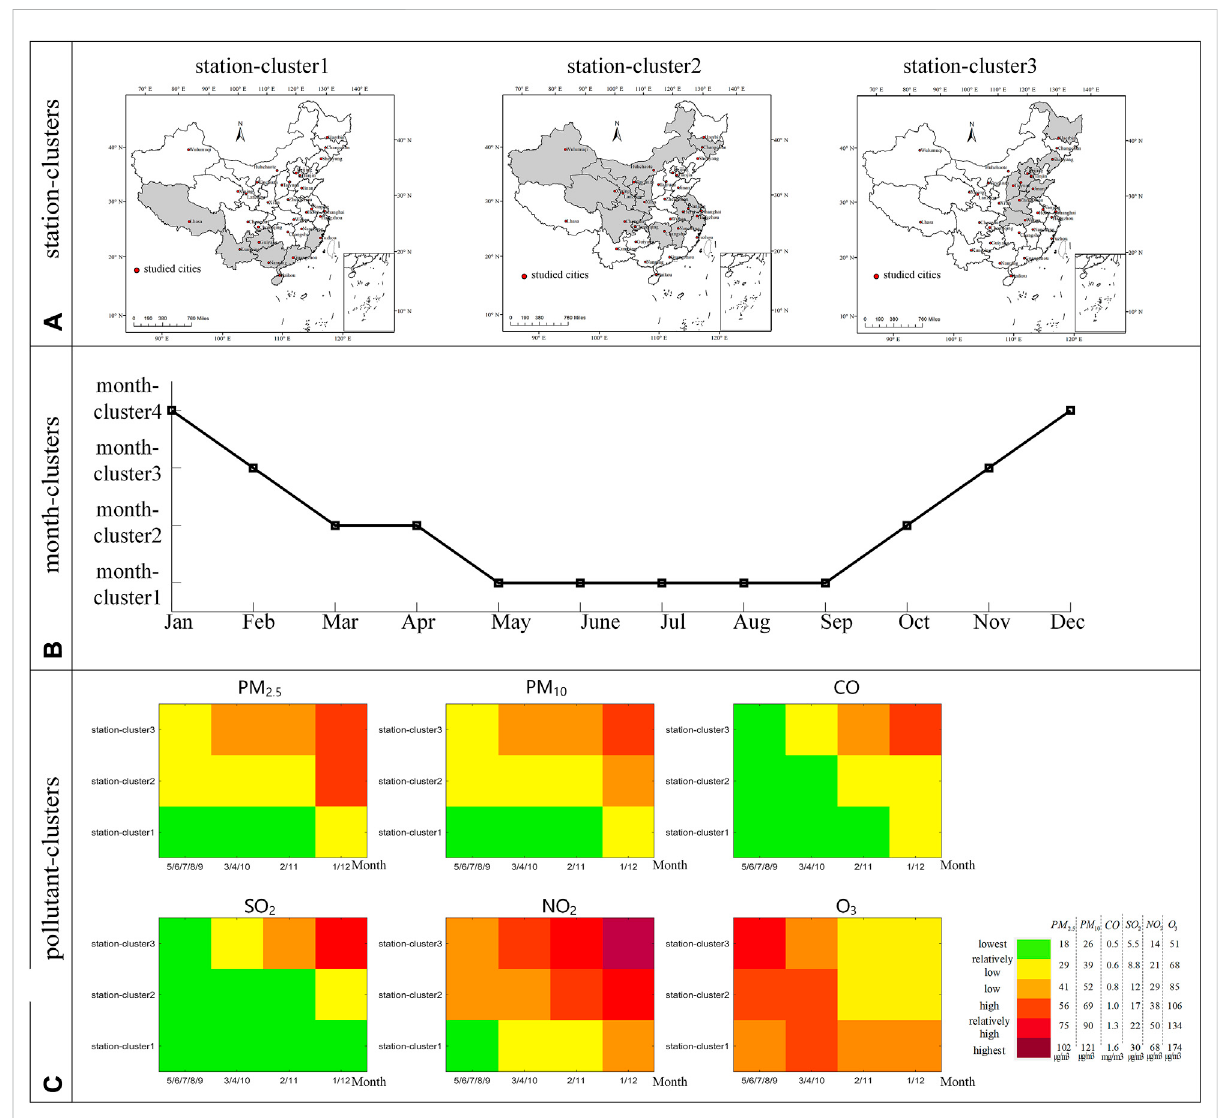
FIGURE 7 (A) Spatial distribution of station clusters with coverage indicated by provinces of corresponding cities (stations) in that station cluster, (B) temporal distribution of month clusters, and (C) variations of air